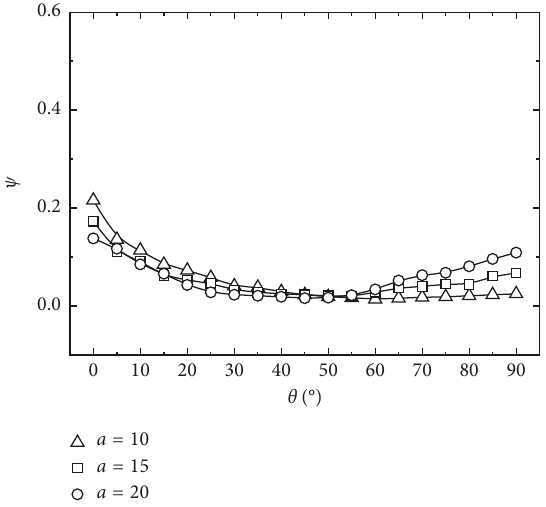
Figure 8: Orientation distribution of cylindrical particles for different a (Re � 200 and St �